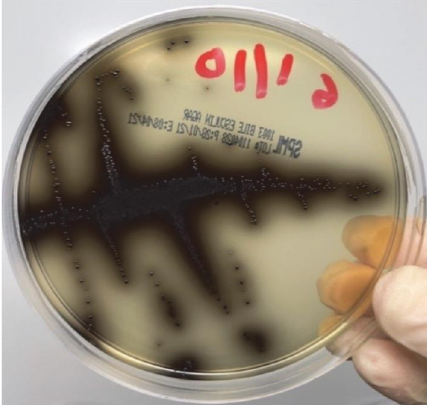
F IGURE 6: Bile esculin agar showing high numbers of growing colo- nies of E. faecalis before application of